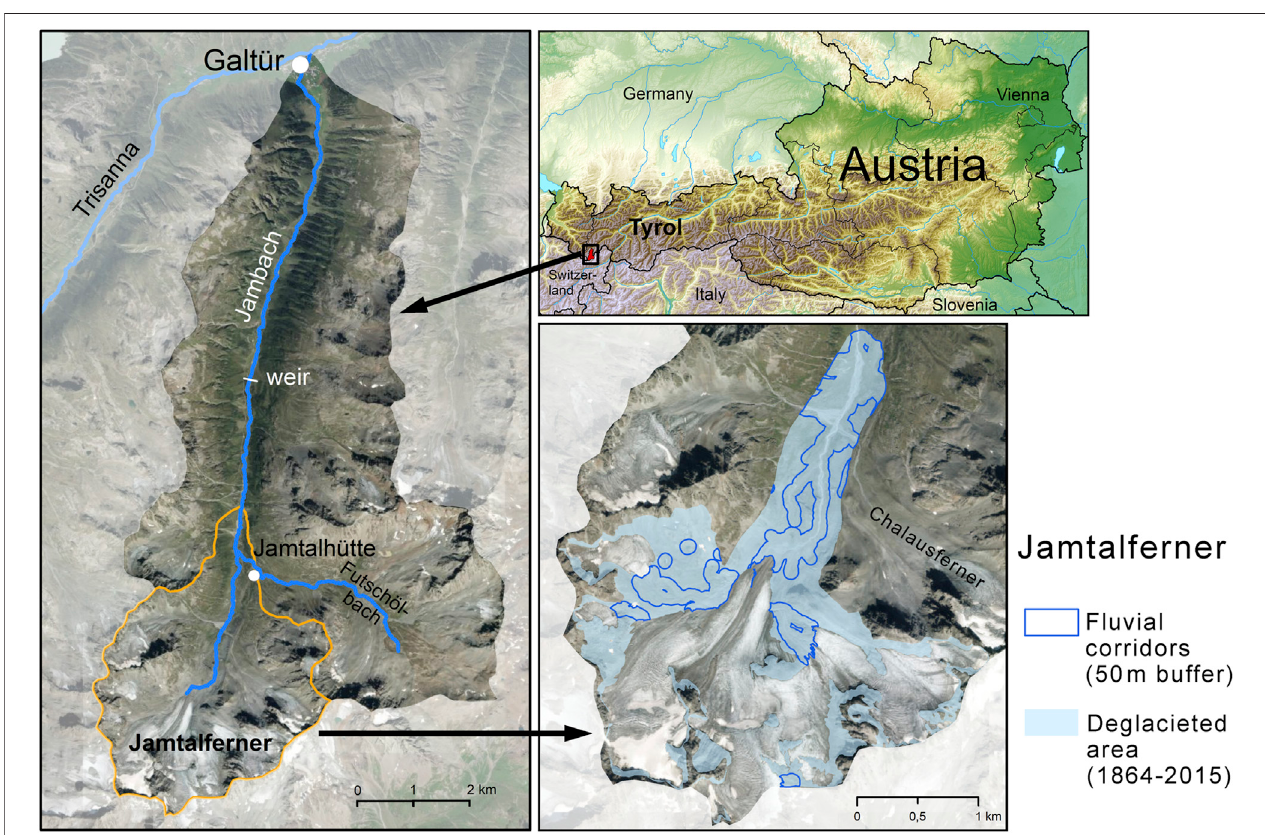
FIGURE 1 | Study area “ Jamtal ” valley south of the village Galtür with the glacier Jamtalferner at the border between Tyrol and Switzerland in 2015 (orange boundary: detail study area “ Jamtalferner subbasin ” ; basemaps: tiris maps, Tyrol; Wikimedia Commons, Tschubby 2018).